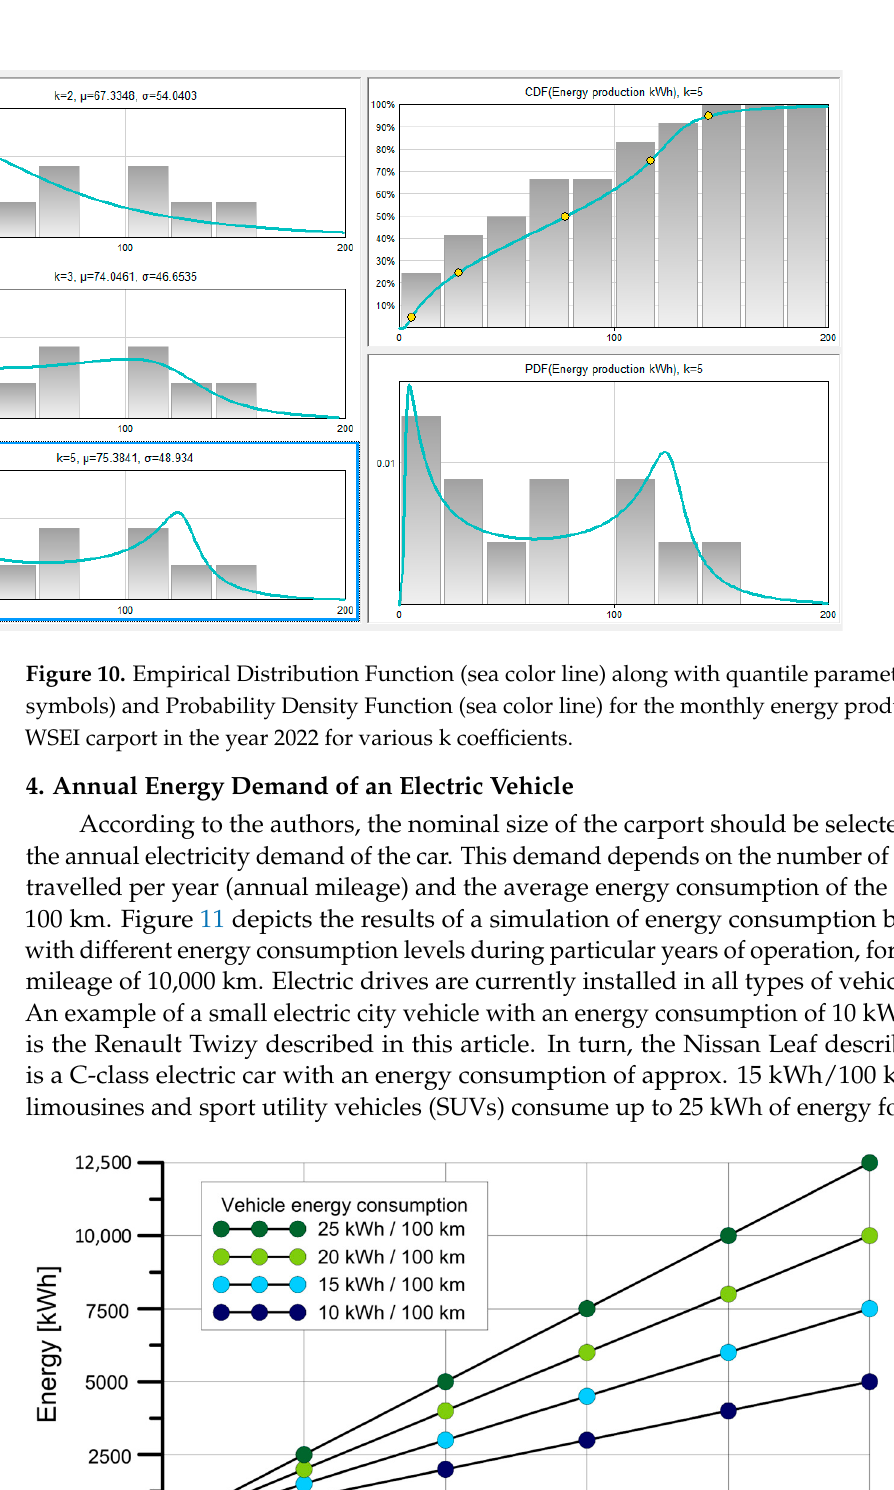
Figure 12. Annual demand for the electric energy of the vehicle with di ff erences in mileage. The results of the electricity demand for vehicles with di ff erent energy consumption levels appear similar if we make calculations depending on the annual mileage of an elec- tric car instead of years (as in Figure 12). The results of such simulations are shown in Figure 12. Both graphs shown in Figures 11 and 12 enable us to easily determine the peak power and thus the size of the photovoltaic carport, depending on the vehicle and annual mile- age. The calculations are based on the assumption that all the energy produced by the carport will be used to charge the EV.